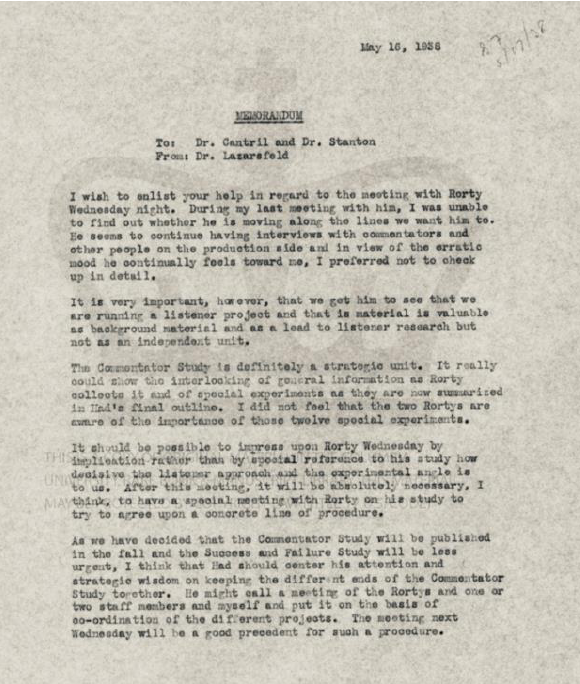
Figure 1. Paul Lazarsfeld, memo to Hadley Cantril and Frank Stanton, May 16, 1938. Columbia University Rare Book & Manuscript Library, New York, reproduced with